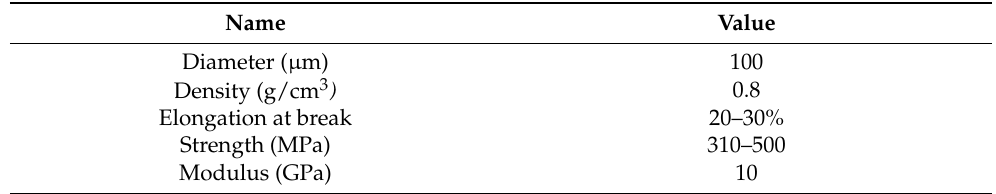
Figure 3. 3D braided composites embedded with CNT yarn sensor. Table 3. The specification parameters of CNT.